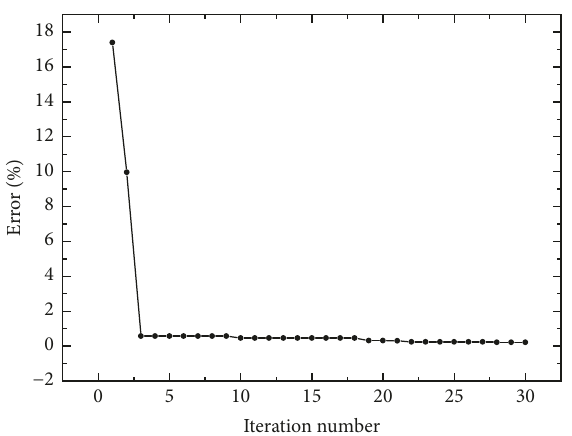
Figure 7: Convergence of the objective function. numerical simulation can be released significantly due to its simplicity and efficiency. (3) Experimental tests were carried out to get the natural frequencies of a composite beam from which their material properties were approximately defined based on the ASTM code. These values were used to initialize the spectral model which was updated by applying a PSO algorithm. The final